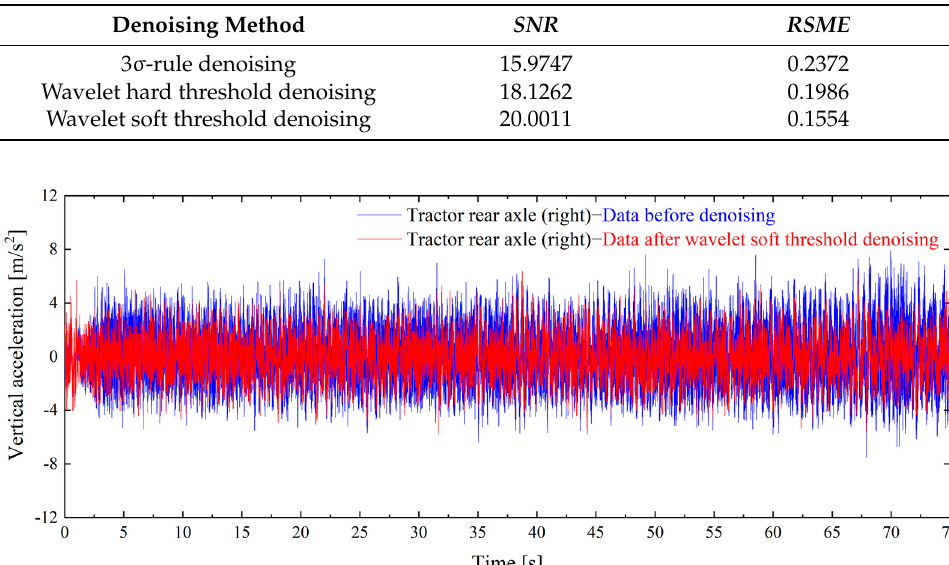
Table 5. Effect comparison of different denoising methods.